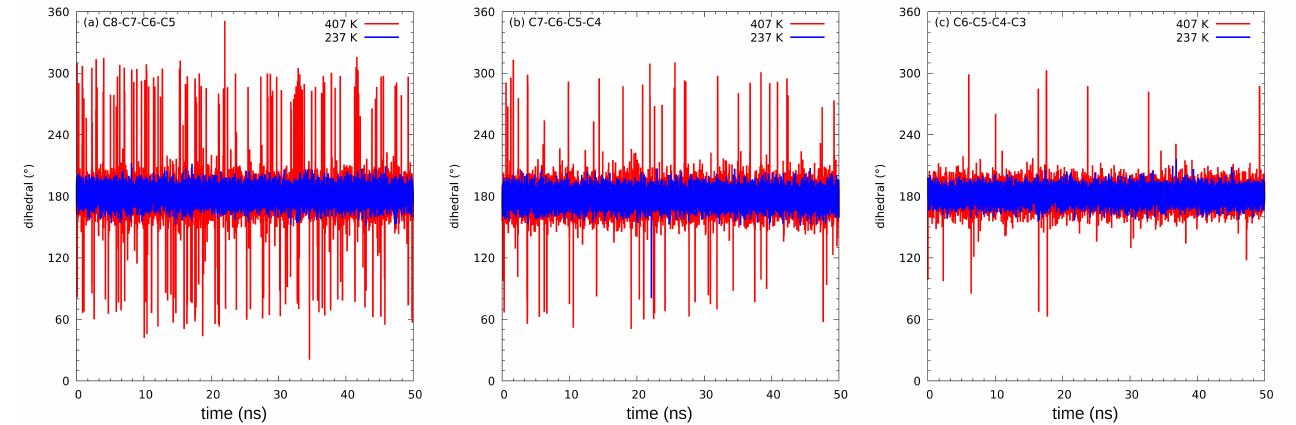
Figure 6. Time evolution of three dihedral angles relevant to the aliphatic chain conformation in selected molecule: ( a ) C8-C7-C6-C5, ( b ) C7-C6-C5-C4, and ( c ) C6-C5-C4-C3 angle. Results of classical MD at 237 K (blue line) and 407 K (red line). Table 1. Number of instances of the indicated dihedral angles being outside the 120 ◦ –240 ◦ range that the region of the native all-trans conformer. Three selected molecules were chosen, and the maximum count is 30,000 frames. Results of classical MD